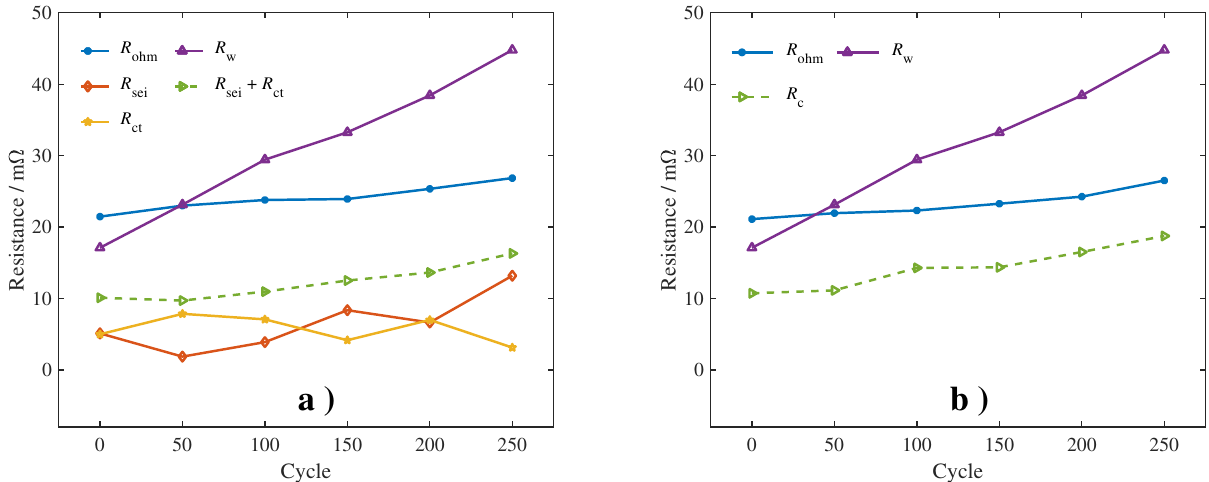
Figure 7. Impedance fitting results under 25 ◦ C@1–1 C condition at 20% SoC with 500 mA excitation based on: ( a ) the second-order equivalent circuit model; and ( b ) the first-order equivalent circuit